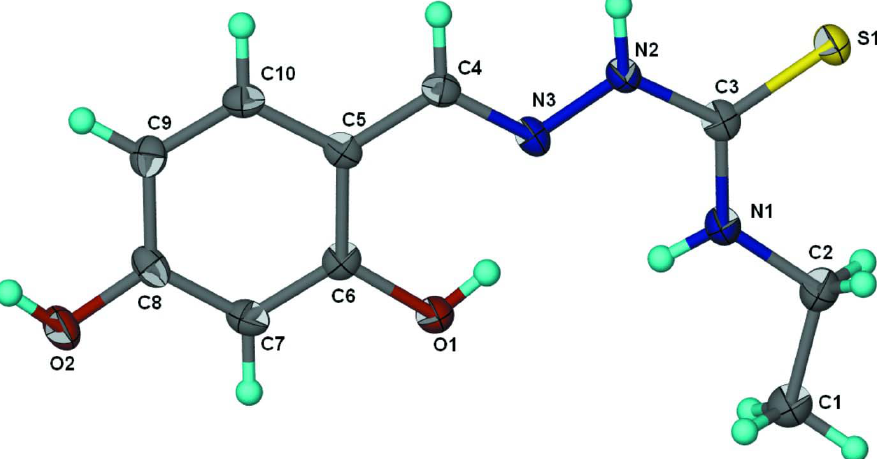
Displacement ellipsoid (Barbour, 2001) plot of the title compound at the 70% probability level. H atoms are drawn as spheres of arbitrary